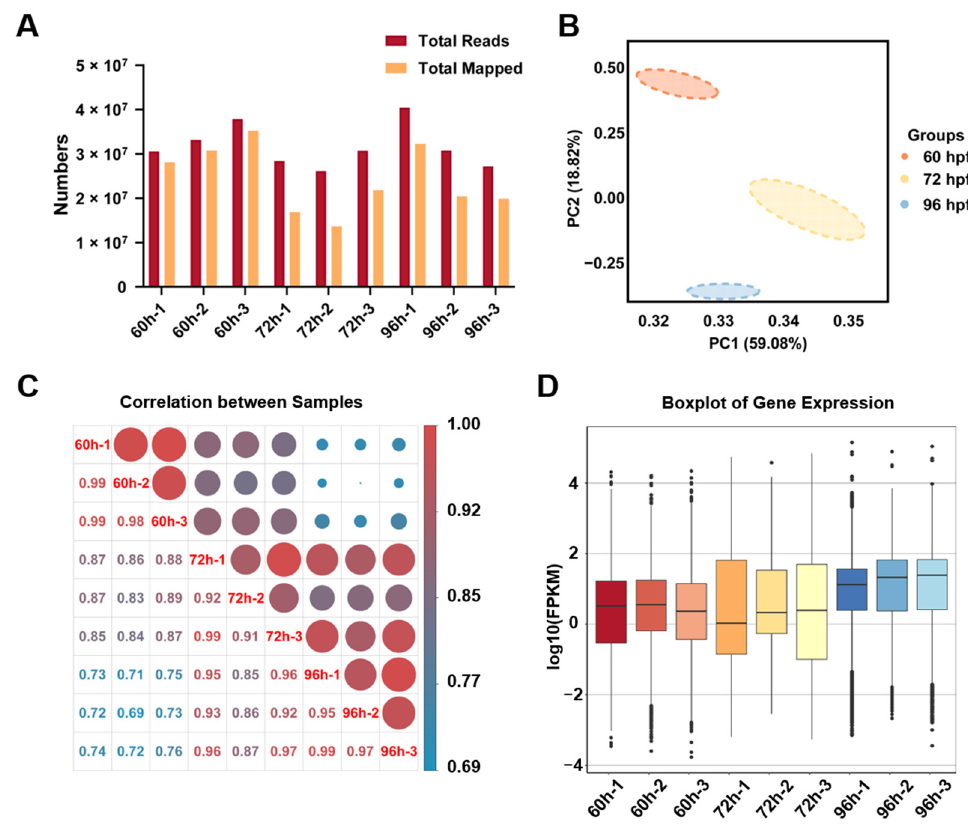
Figure 2. The quality analysis of transcriptome data for zebrafish hepatocytes. ( A ) The RNA-seq data of sorted liver cells at three time points. ( B ) The principal component analysis (PCA) of samples at three time points. ( C ) The Pearson’s correlation coefficient matrix of RNA-seq between samples at three time points. ( D ) The boxplots of gene expression in samples at three time points. Table 1. Statistics of RNA-seq output data.